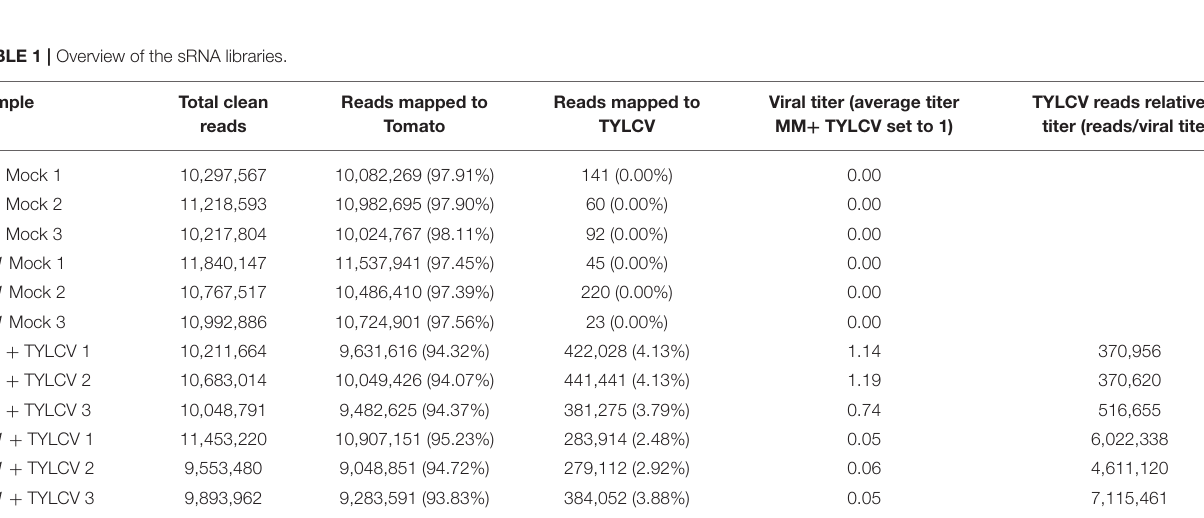
FIGURE 1 | Symptoms and viral titers in MM and Ty-1 bearing tomato. (A) Symptoms upon infection with TYLCV or mock infection in respectively Ty-1 introgression tomato and susceptible MM at 29 days post infection. (B) Quantification of TYLCV titer in MM and the Ty-1 introgression line. Values were normalized to actin and calibrated to the levels in MM plants (set to 1). Every bar represents the average viral titer and standard deviation based on technical replicates of individual plants.